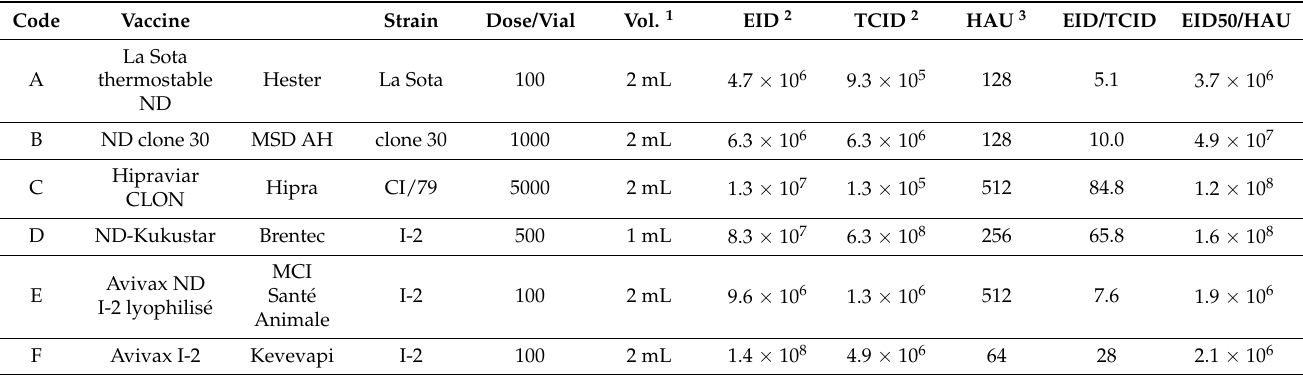
Table 1. Tested live Newcastle disease